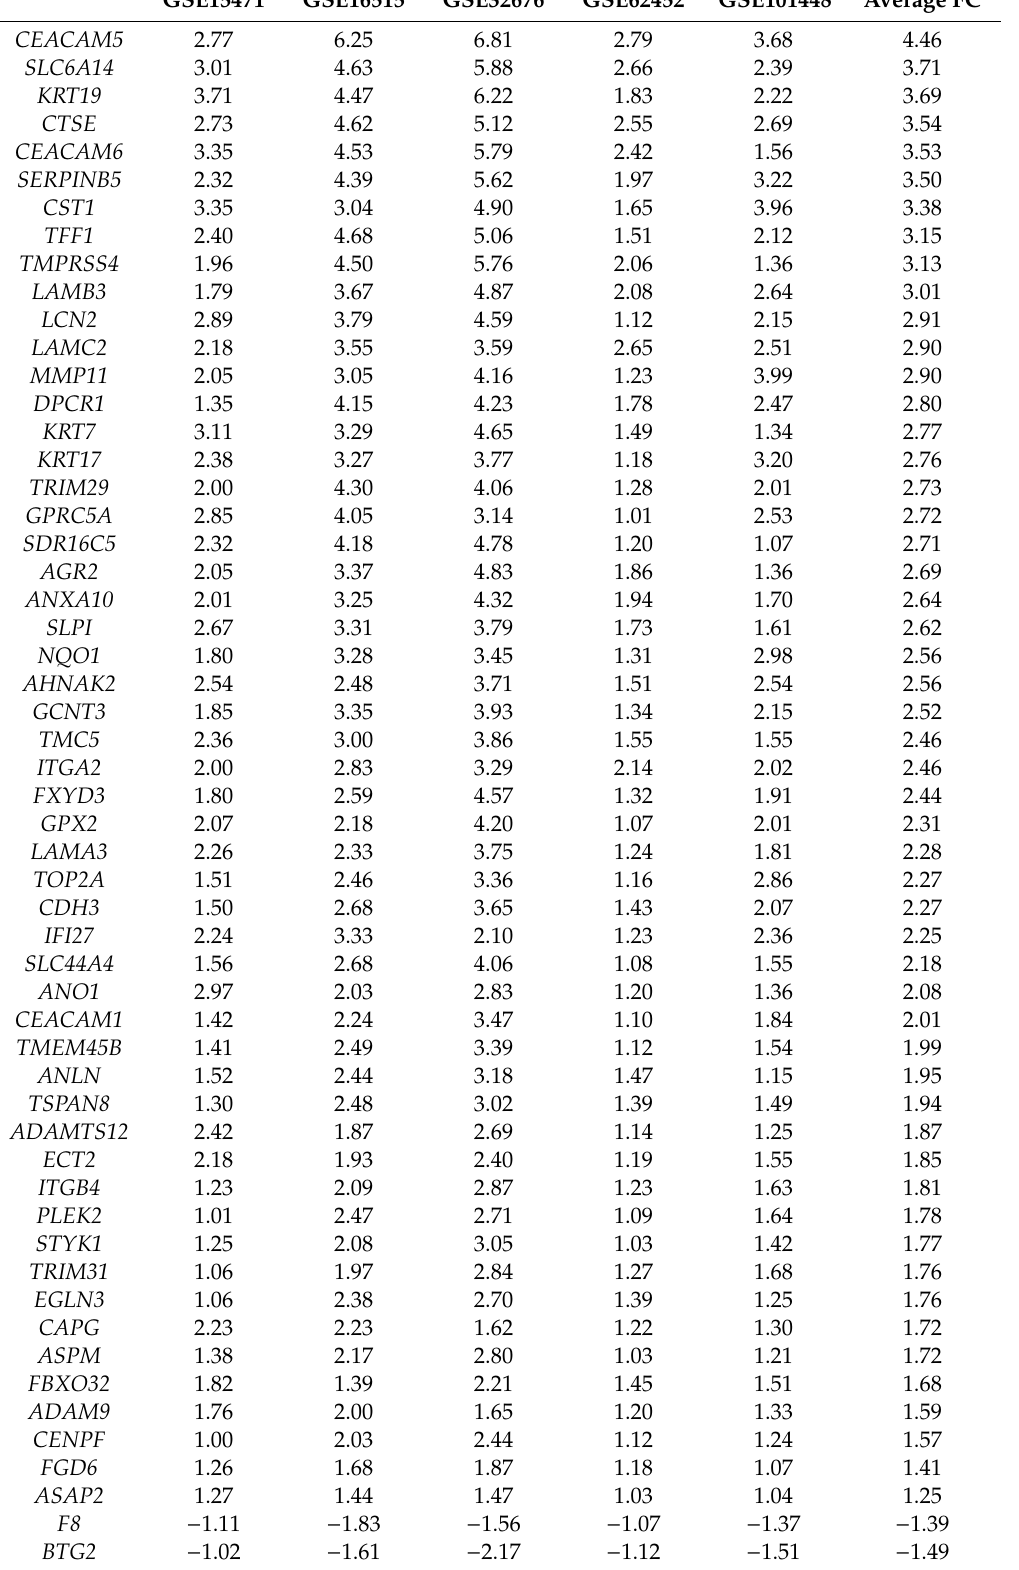
Table 2. The common gene signature in pancreatic ductal adenocarcinoma and the gene FC